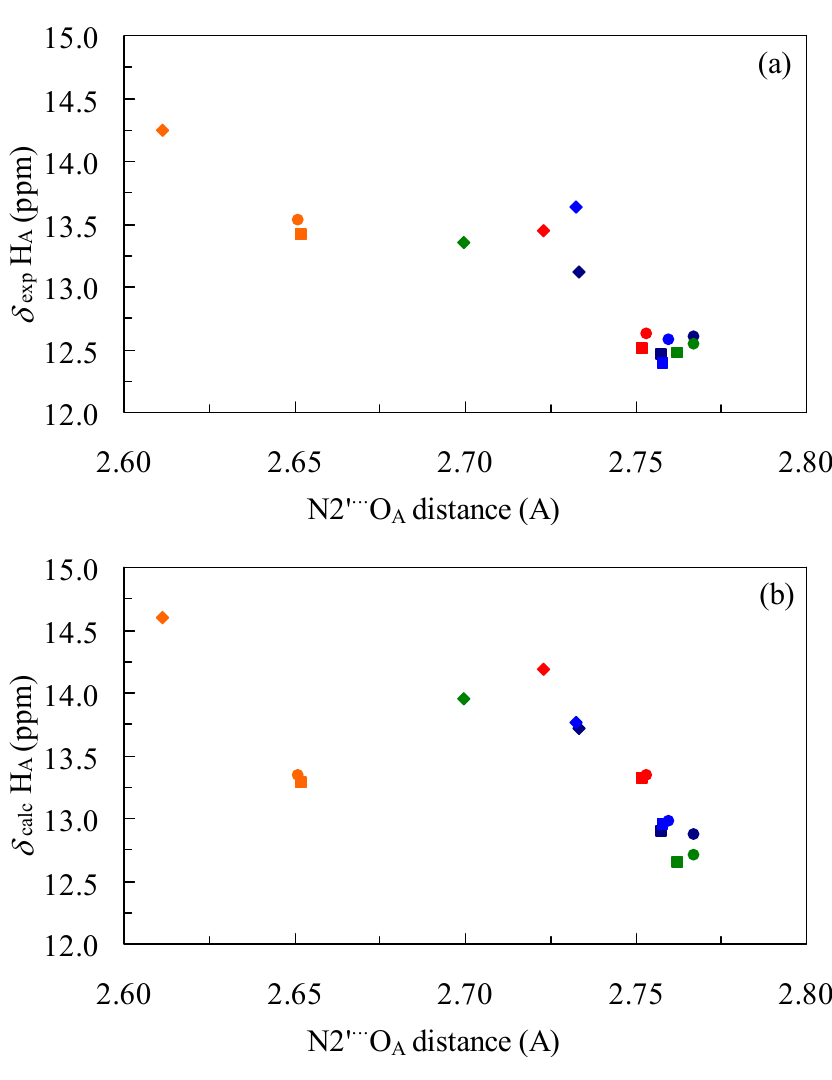
Fig. 10 Plots of experimental (a) and calculated (b) 1 H-NMR chemical shifts of H A vs. the N2 (cid:2) ... O(4) internuclear